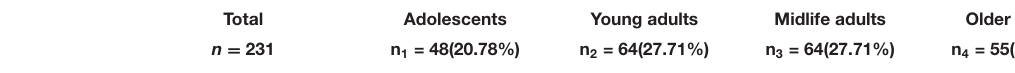
TABLE 3 | Comparison of results of